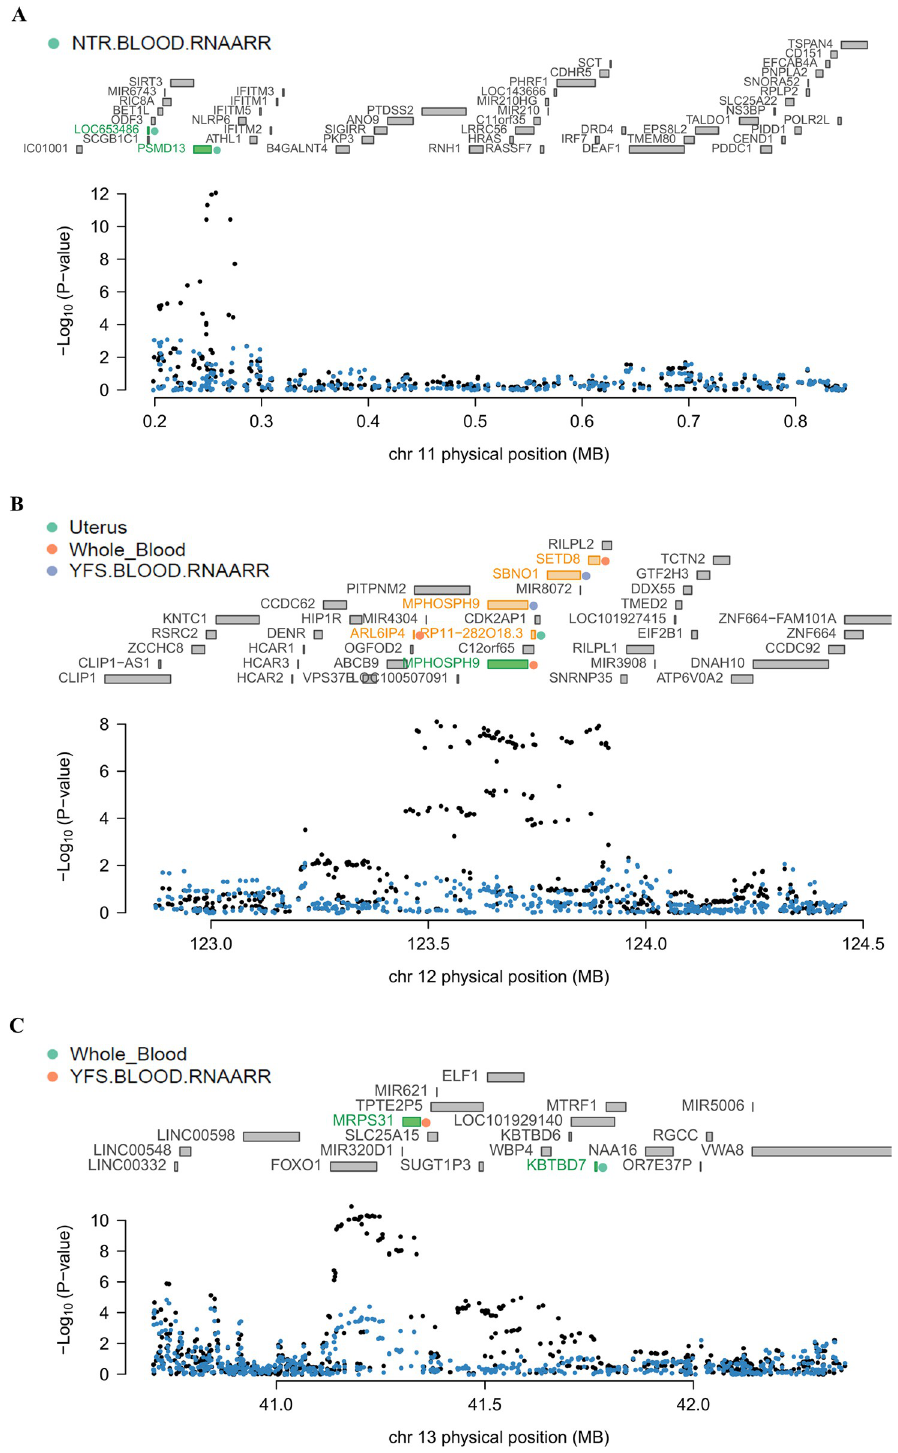
Fig 2. Regional association plots showing conditional and joint analyses results. ( A ) The regional association plot of chromosome 11. ( B ) The regional association plot of chromosome 12. ( C ) The regional association plot of chromosome 13. The middle part of each figure represents all genes located in the region. The green bars indicate jointly significant genes that are responsible for most GWAS signals in the region, the yellow bars represent TWAS genes that are no longer significant after accounting for conditionally independent genes, and the gray bars indicate